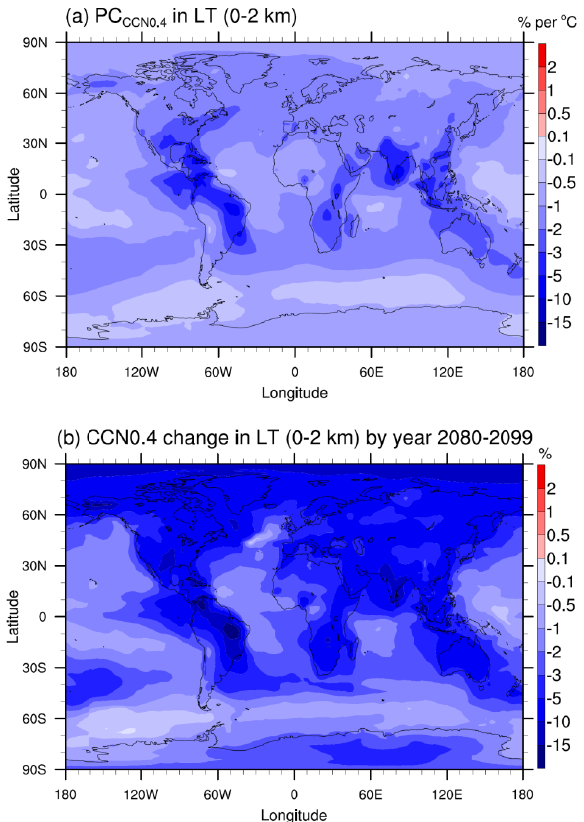
Figure 6. Fig. 6. Sensitivity of CCN0.4 to temperature change (% per ◦ C) in the lower troposphere (0–2km), and the scaled total CCN0.4 change (%) toward the end of this century (2080–2099 period) based on NCAR CCSM3 projected global temperature changes correspond- ing to IPCC-DDC 4th Assessment Report Scenario